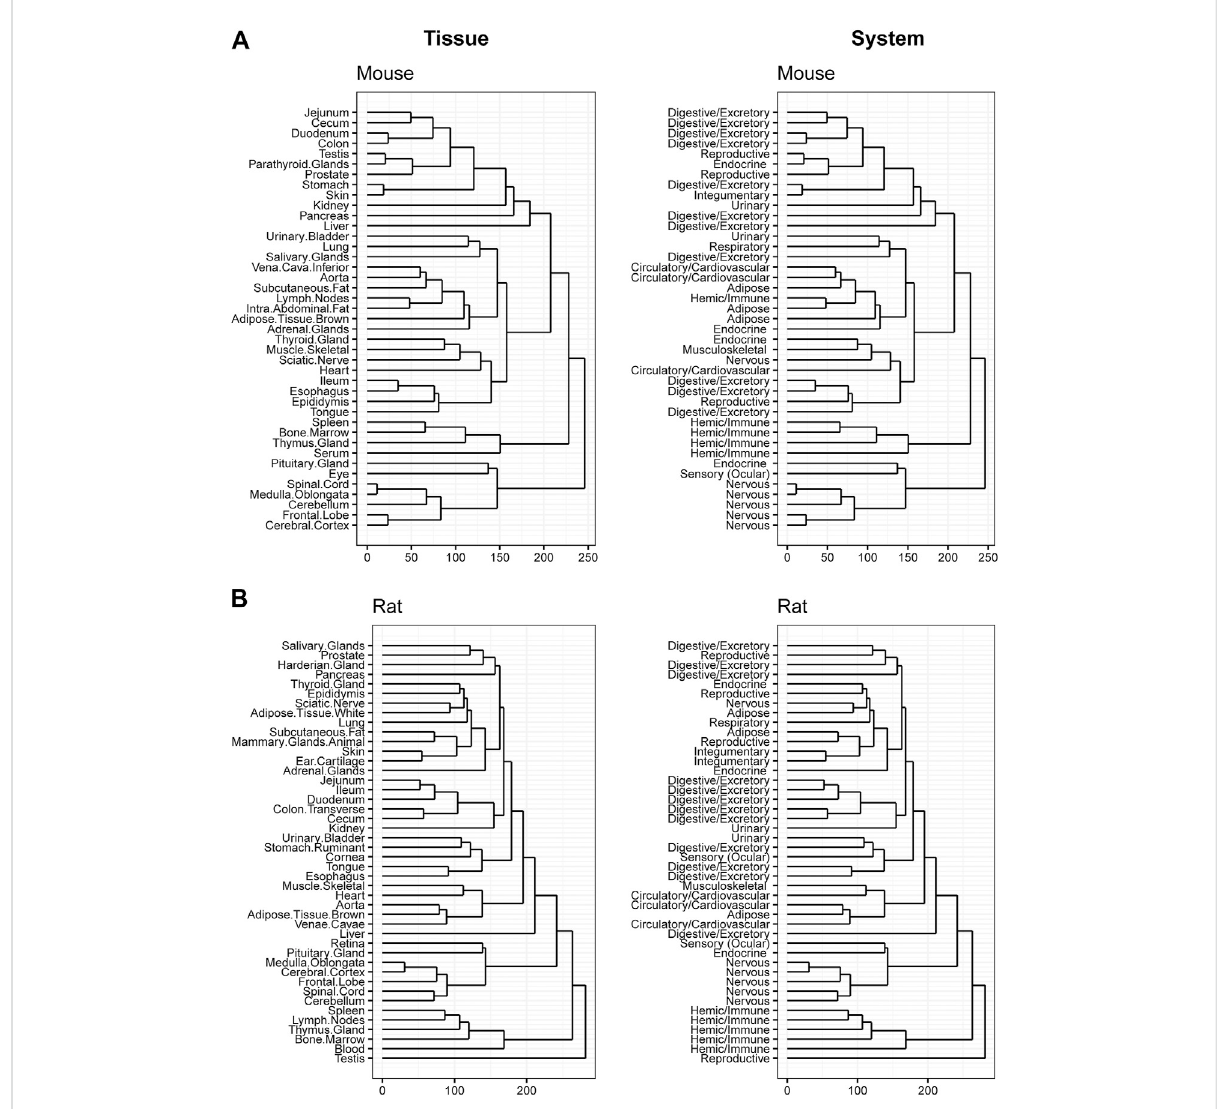
FIGURE 4 HierarchicalClusteringofTissuesinMouseandRat.Dendrogramtovisualizehierarchicalclusteringofmaletissues(left)inmouse (A) andrat (B) . These tissues were also mapped to broader organ/system classi fi cations